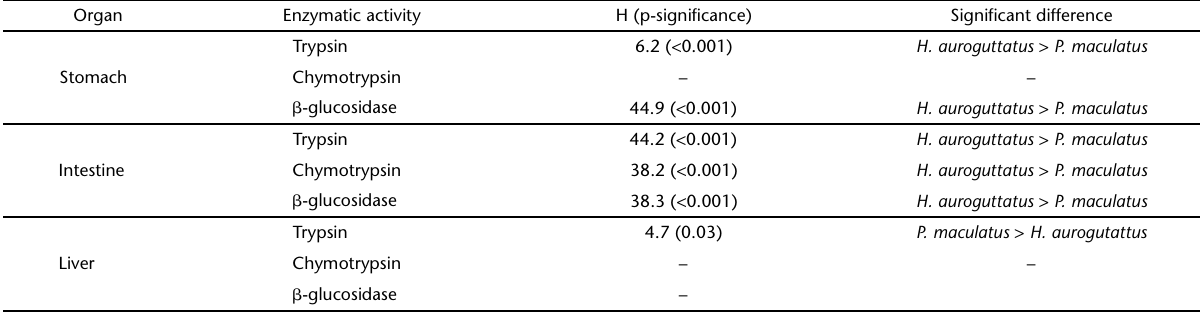
Table I. Significant differences for enzymatic activity in organs between Hypostomus auroguttatus and Pimelodus maculatus , according to non-parametric Kruskal-Wallis test. H and P-significance are shown. Organ Enzymatic